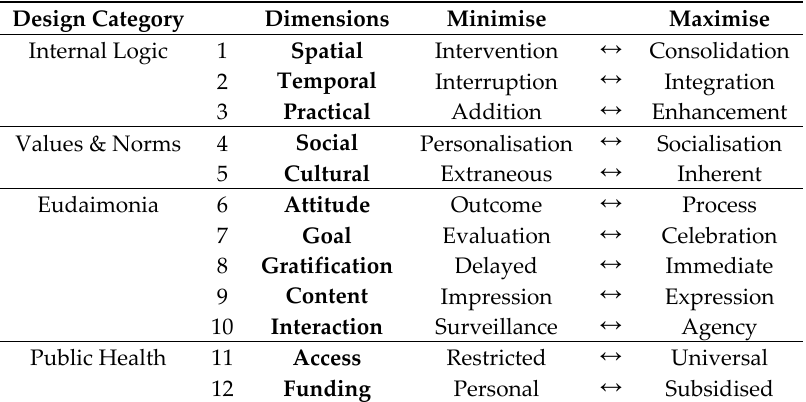
Table 1. Compliant Sports Augmentation